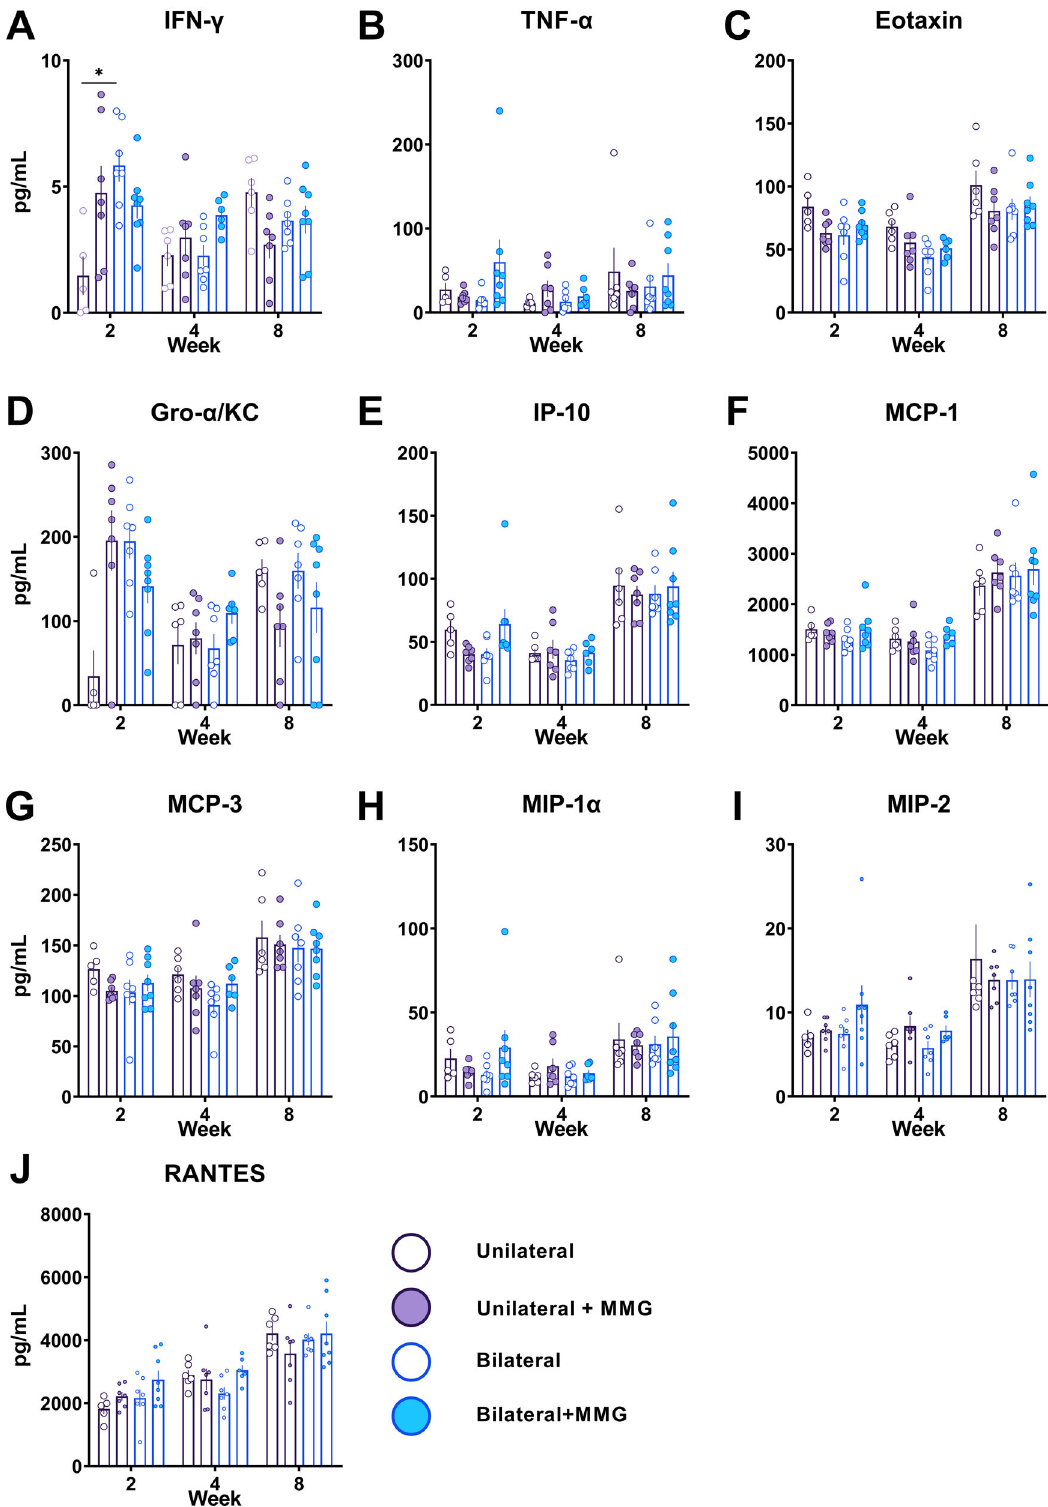
Fig. 1 Changes in systemic chemokines and cytokines in bilateral and unilateral injured animals. Quanti fi cation of serum collected at 2, 4, and 8 weeks post-VML injury for A interferon-gamma (IFN- ℽ ), B tumor necrosis factor-alpha (TNF- ɑ ), C Eotaxin, D Gro-alpha/keratinocytes- derived chemokine (Gro- ɑ /KC), E Interferon gamma-induced protein 10 (IP-10), F monocyte chemoattractant protein-1 (MCP-1), G MCP-3, H macrophage in fl ammatory protein 1-alpha (MIP-1 ɑ ), I MIP-2, and J regulated on activation, normal T cell expressed and secreted (RANTES). Data is presented as mean ± SEM. * = P <